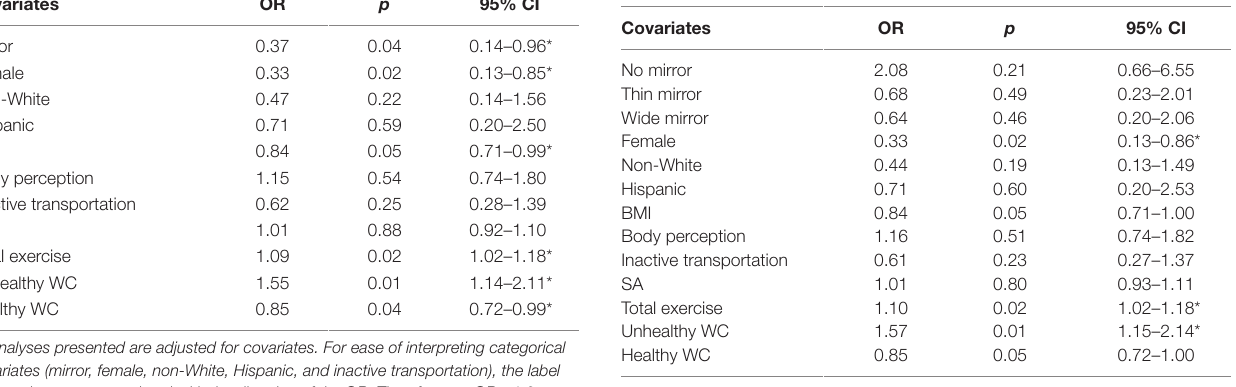
TaBle 3 | Odds ratios (Or) for stair use among individual mirror conditions.